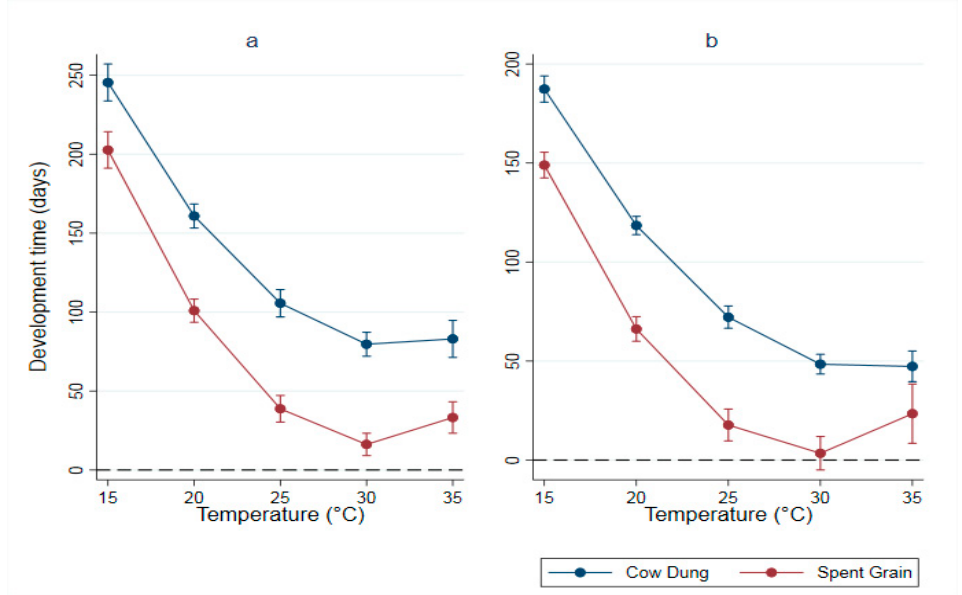
Table 7). The mean temperature threshold for SG-fed pupae was not significant.